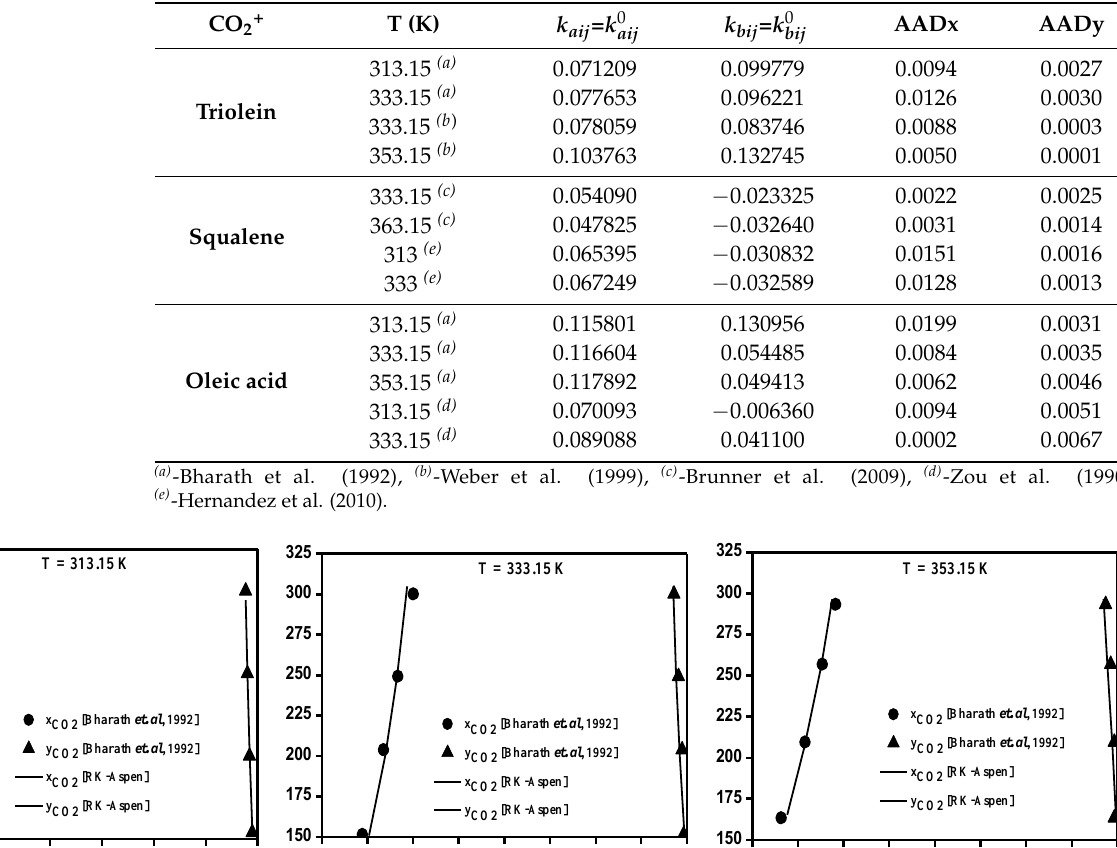
Table 12. RK-Aspen EOS k aij = k 0